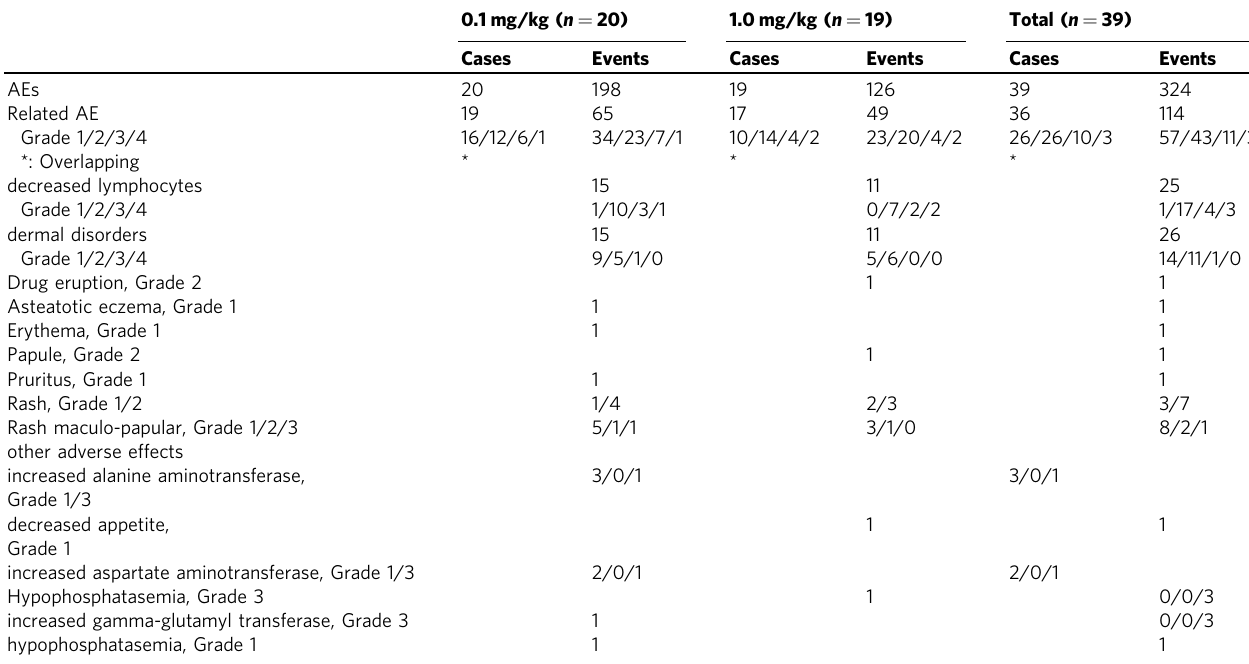
Table 2 Adverse effects of mogamulizumab